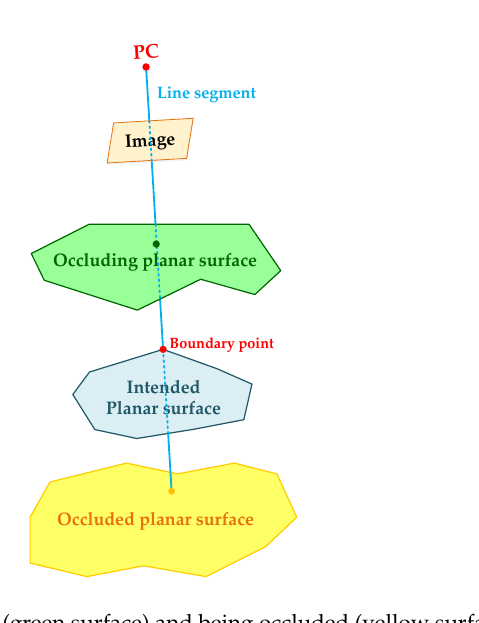
Figure 9. Occlusion investigation of a boundary point of the intended planar surface within a given image ( a ) visible boundary point ( b ) occluded boundary point.